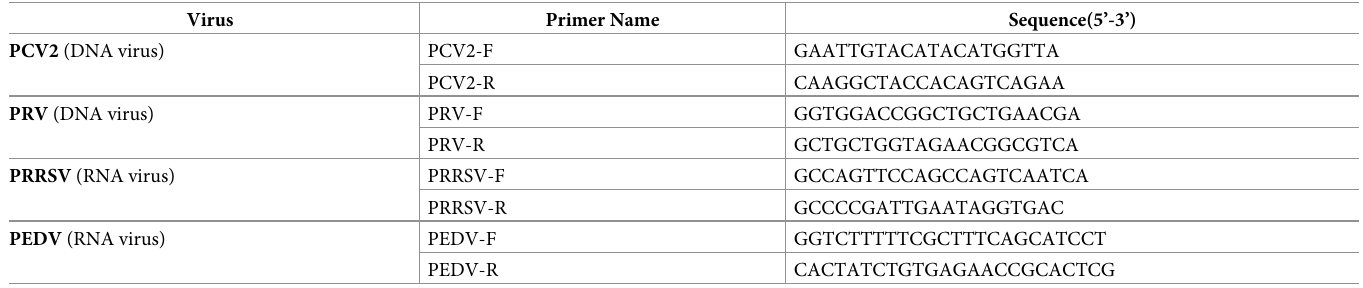
Table 3. Detection of common viruses in pigs with specific